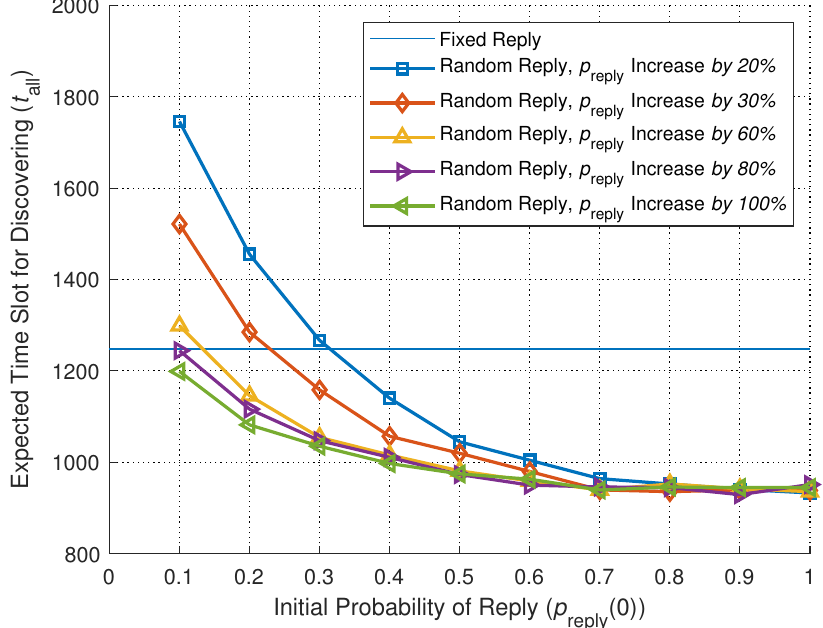
Figure 14. Discovery time vs. p reply